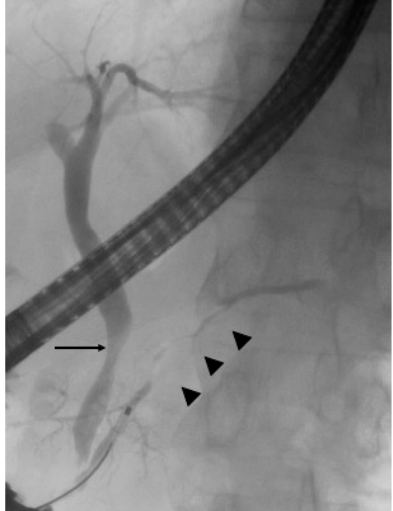
Figure 1. Endoscopic retrograde pancreatography revealed diffuse irregular narrowing of the main pancreatic duct (arrowhead) and stenosis of the lower bile duct (arrow).